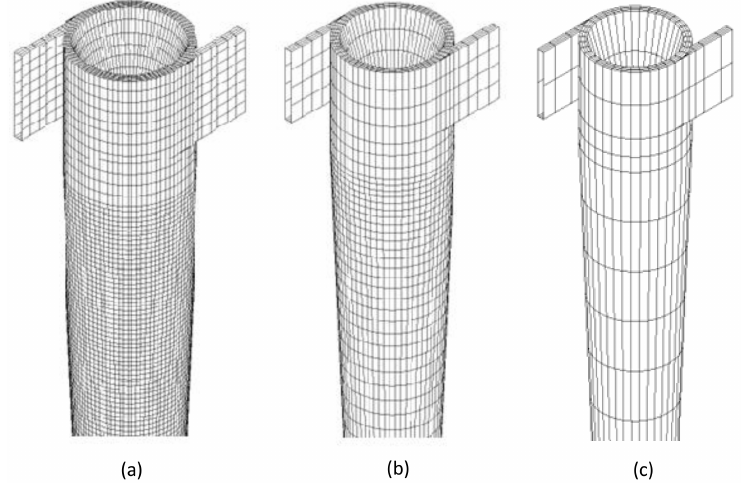
Figure 3. Details of the meshes produced: ( a ) Mesh M1; ( b ) Mesh M2 and ( c ) Mesh